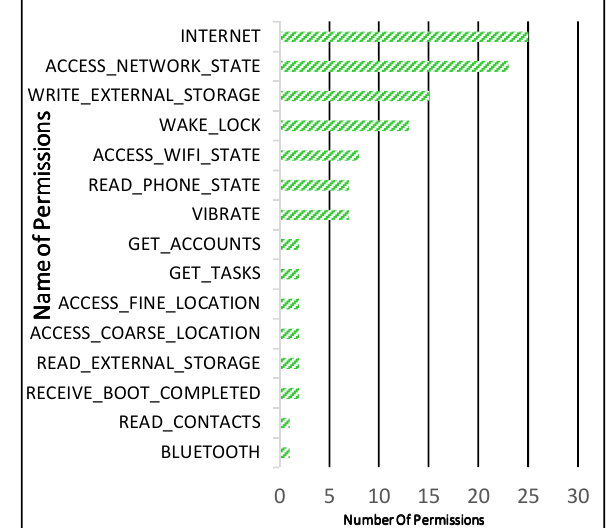
Fig. 7: Permissions Requested by Benign Game